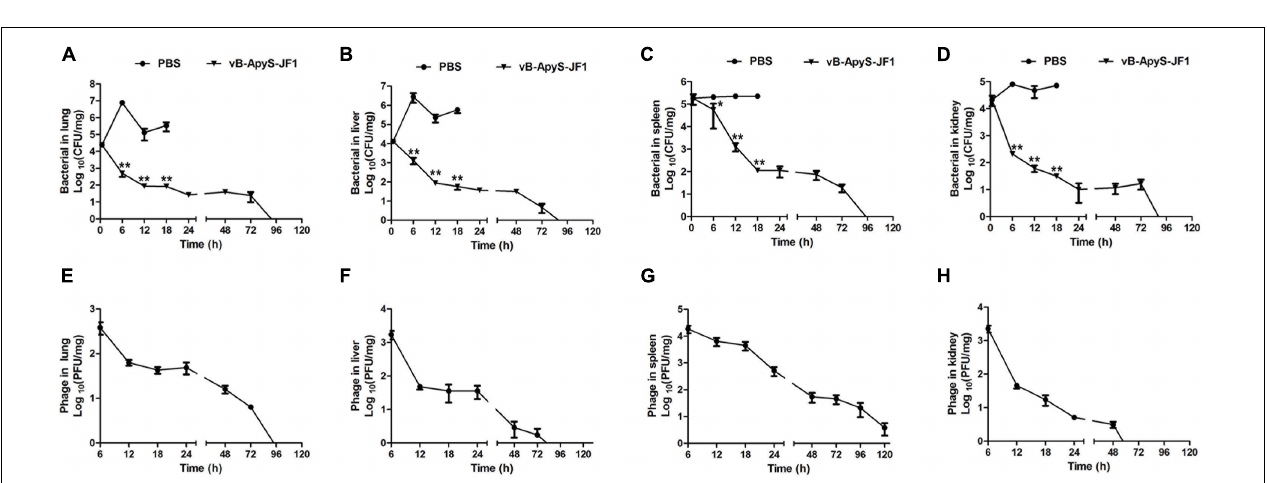
FIGURE 6 | Determination of bacterial load and phage titers in blood samples of mice. Blood samples were collected from mice of each group 1, 2, 3, 4, 5, 6, 12, 18, 24, 30, 36, 42, 48, 60, 72, 84, and 96 h after challenge. Three mice from each group were euthanized at each time point. (A) Each blood sample was diluted multiple times, and the colony counts were determined. (B) The titers of phage JF1 were measured using the double-layer plate method. The values represent the means and SDs ( n = 3). ** P < 0.01.